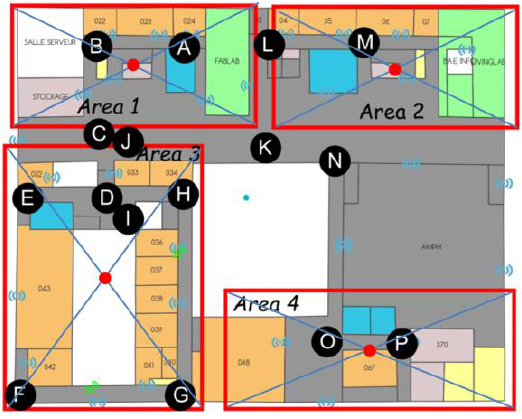
Figure 13. Definition of the central points for any given area (in red). Table 3. Accuracy of the proposed approach with respect to the applied positioning method.